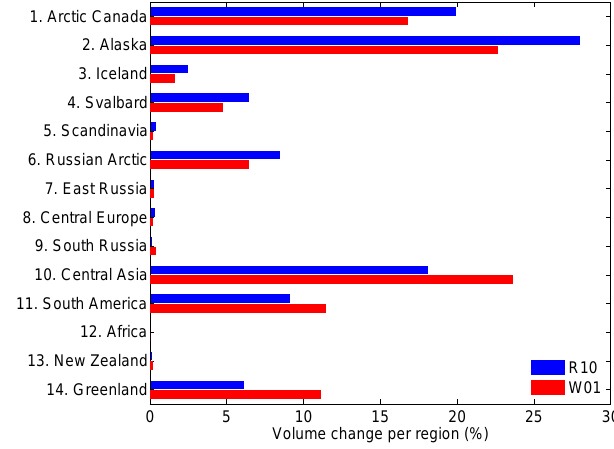
Fig. 8. GIC sea-level contribution per region relative to total δV .